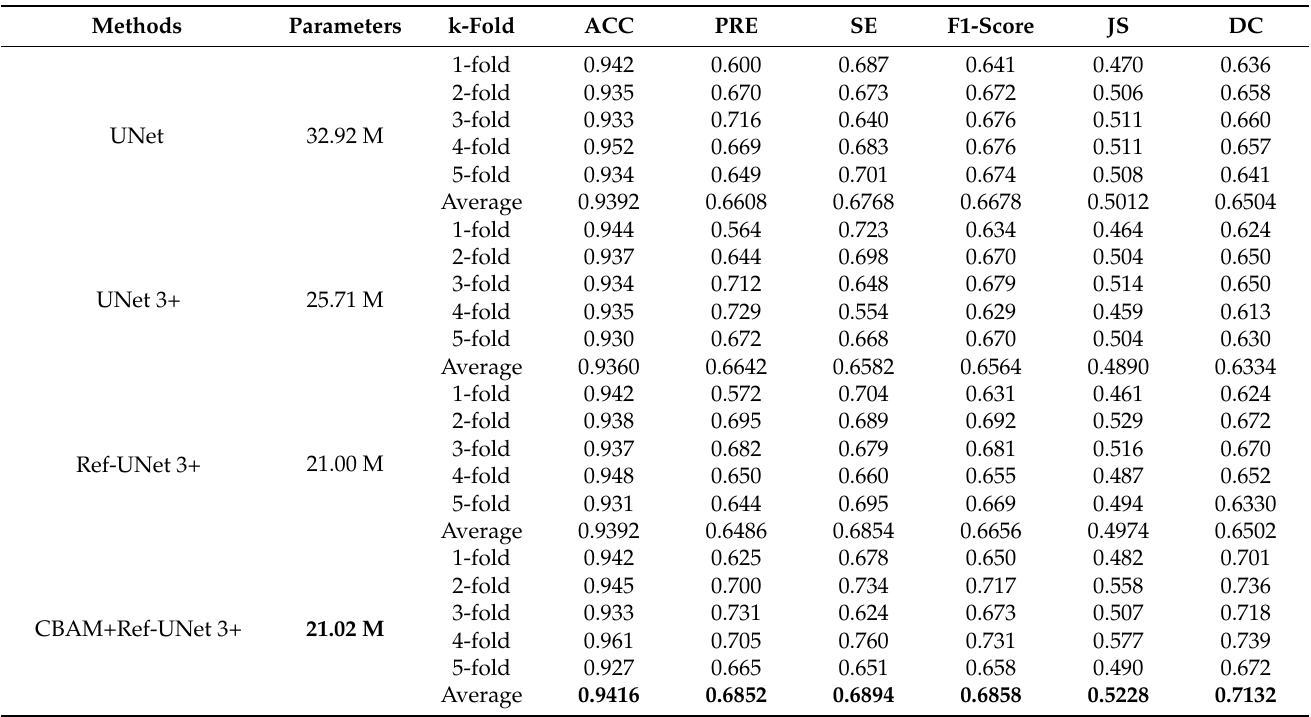
Table 2. Experimental results of proposed methods for breast cancer segmentation and comparison against other methods. The bold data denotes the best one.